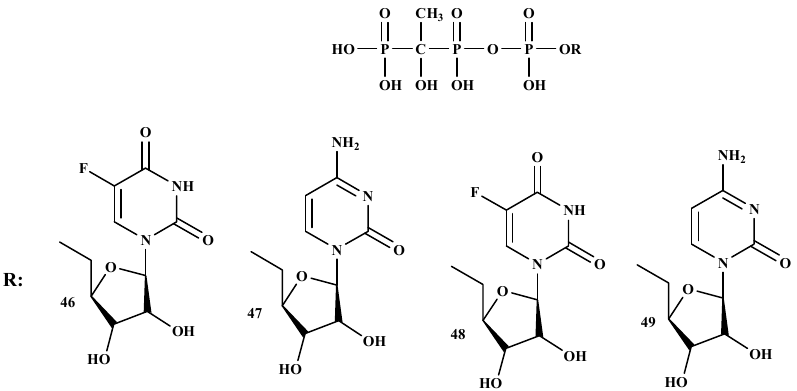
Figure 9. BP ‐ conjugates 46–49, potential compounds for the treatment of Tumor ‐ induced bone disease.